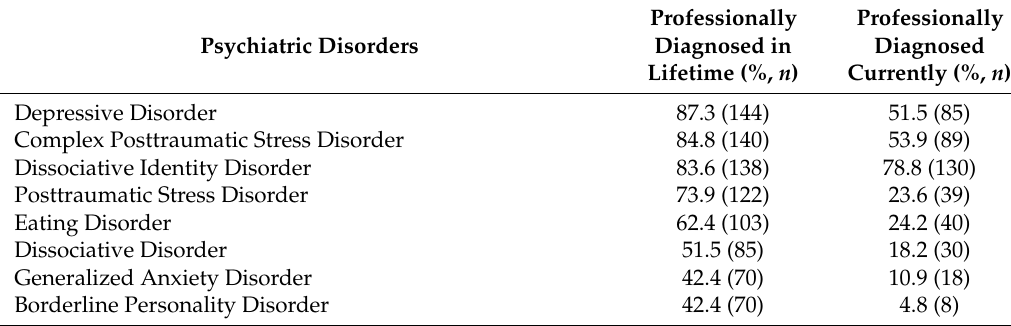
Table 4. Prevalence rates of psychiatric disorders diagnosed by health care professionals, according to self-reports by self-identified ORA victims ( n =